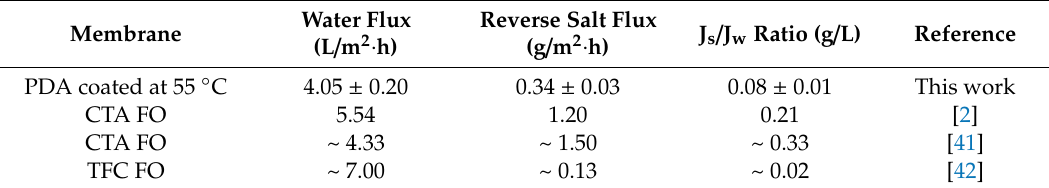
Table 2. Water flux, reverse salt flux, and J s / J w ratio of the PDA membranes coated at 55 ◦ C, CTA, and TFC commercial FO